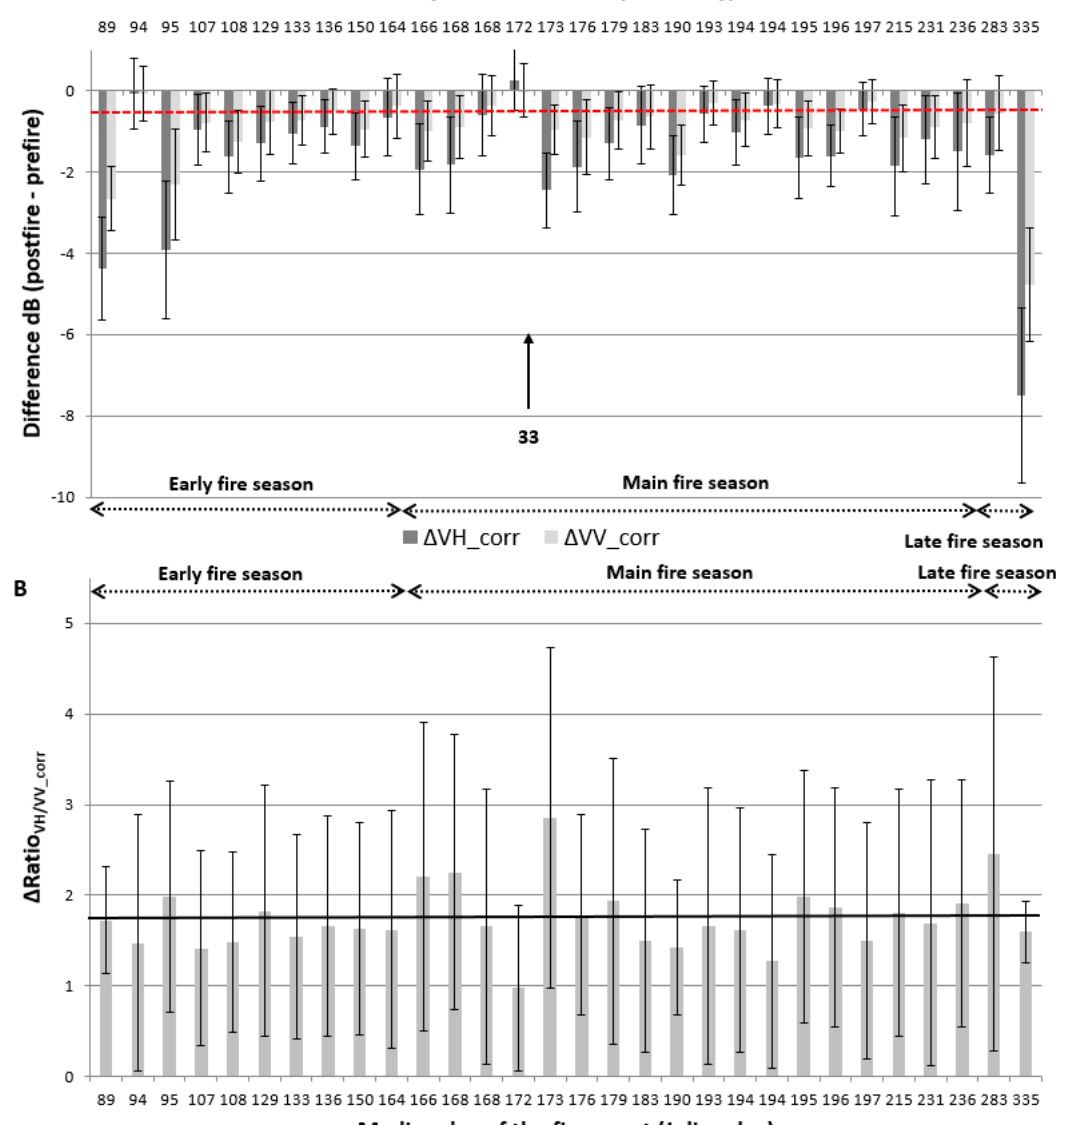
Figure 9. ( A ) Mean pre-fire to post-fire backscatter di ff erences ∆ VV _ corr and ∆ VH _ corr for each of the 30 KNP burn events in 2015, ( B ) ratio of the mean VH and VV di ff erences ∆ ratio VH / VV _ corr , corrected for non-fire related environmental changes. Whiskers shows the standard deviation. The horizontal dashed red line in (A) shows the Sentinel1-A radiometric accuracy reported by [68], 0.43 dB. The plain line in (B) shows the mean ∆ ratio VH / VV for all 30 KNP burn event.